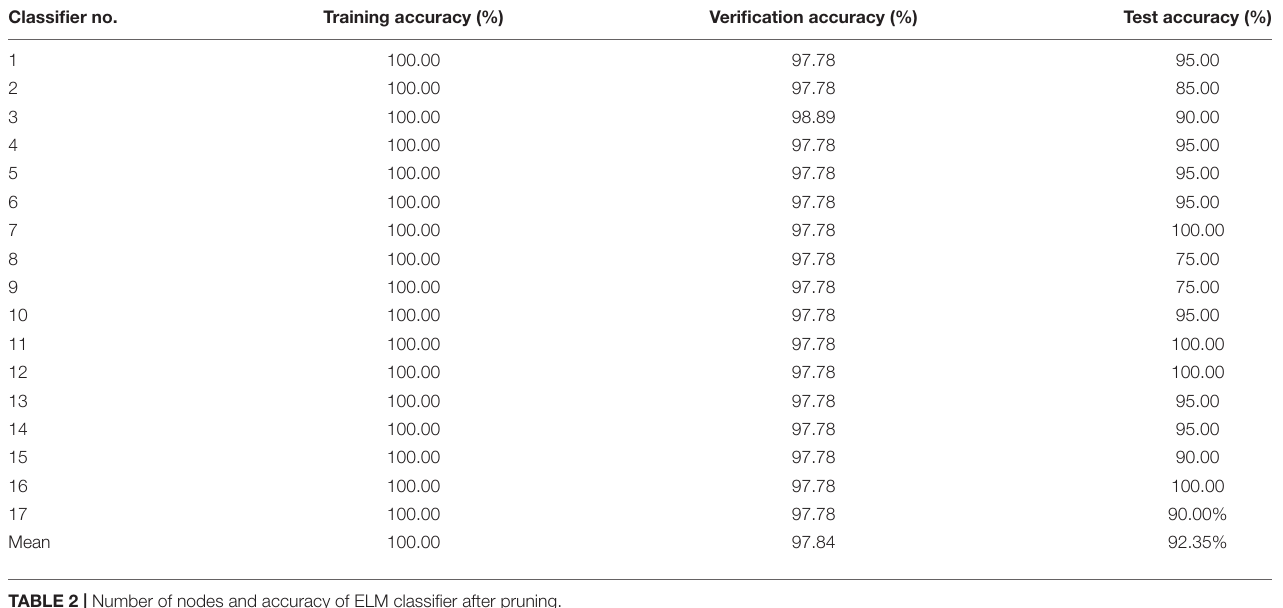
TABLE 2 | Number of nodes and accuracy of ELM classifier after pruning. Classifier